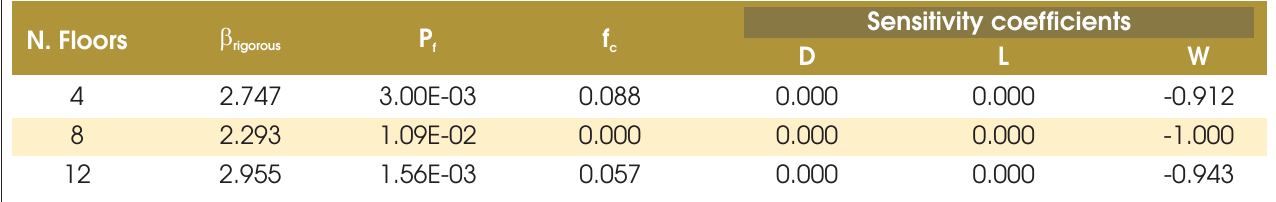
Table 9 – Results for 50-year extreme wind load combined with arbitrary-point-in-time life load